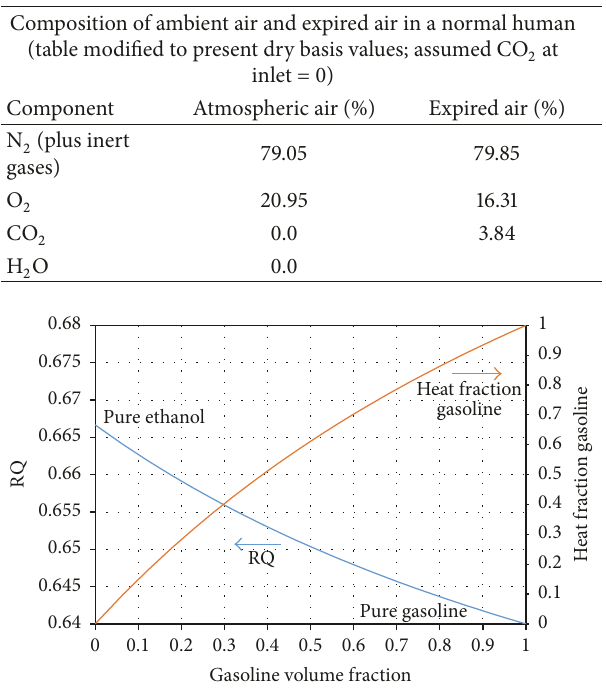
Figure 7: Heat fraction contributed by gasoline and RQ of mixture for known volume fractions of gasoline. Assume the following mixture burned: gasoline (C 8 H 18 ) and ethanol (C 2 H 6 O). HHV 14 , 200 kJ/kg of O 2